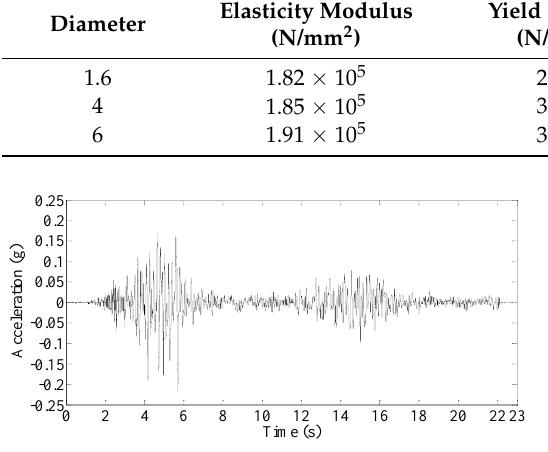
Figure 7. Table excitation for the shaking-table test.